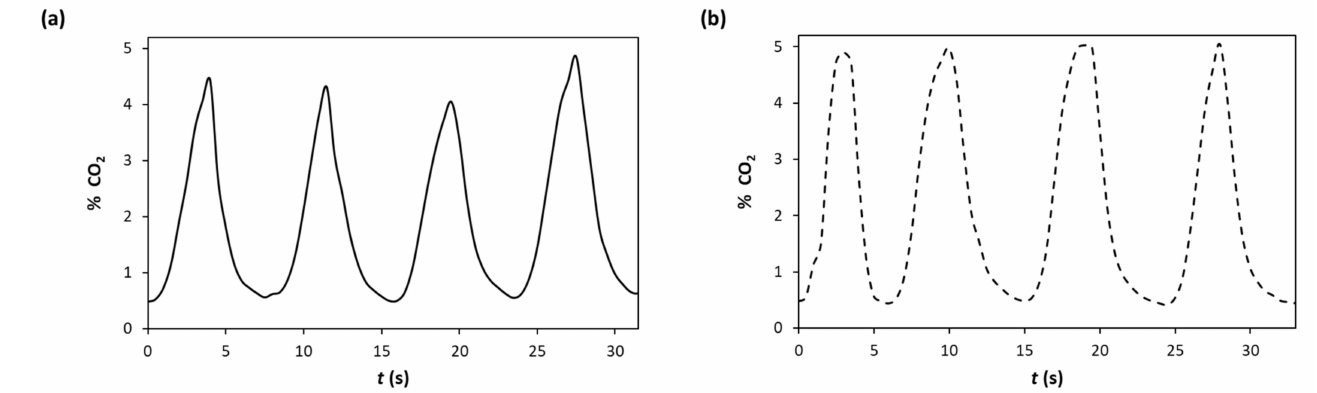
Figure 6. Plot of the % CO 2 vs. time profiles recorded using a ( a ) lab-based capnography indicator and ( b ) Easy Cap indicator, when exposed to a cycle of inhaled and exhaled breath. Each profile was constructed using DCA to determine A (cid:48) at any time t , and Equation (5) and the appropriate value of α to then convert it to a value of % CO 2